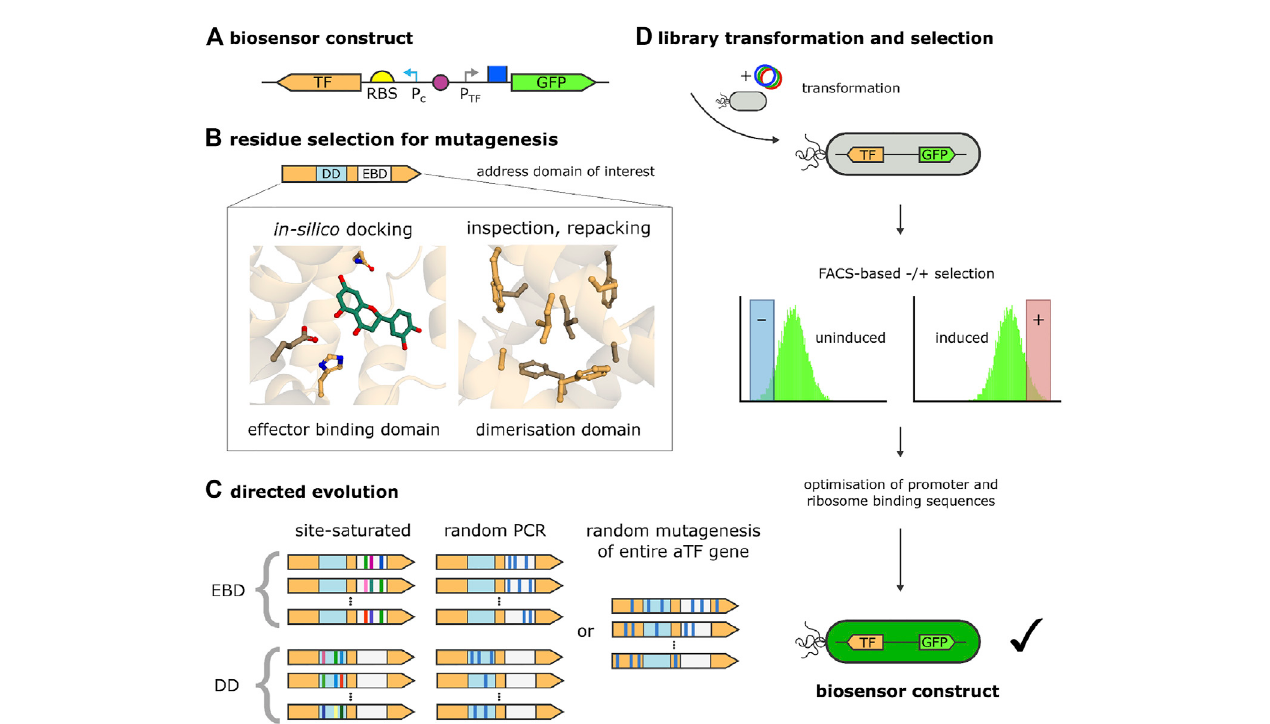
FIGURE 3 Biosensor development by directed evolution of the aTF. (A) Biosensor construct on one plasmid, composed of the sensor component, which, in turn, contains the transcription factor (TF) gene with a ribosome binding site (RBS) and a consecutively active promoter (P c ), and the reporter component, comprised of a TF-inducible promoter (P TF ) and a reporter gene (green fl uorescent protein, GFP). (B) Biosensor mutagenesis strategies. Depending on the availability ofstructuralinformation, adomainofinterestoftheTF(e.g.,theeffectorbindingdomain,EBD,orthedimerisationdomain,DD)areinspected ormodeledandresiduesorsequencestretchesformutagenesisareselected.Toguidemutagenesis,ligandscanbeplacedintotheEBDwith insilico -docking and side chains can be designed and repacked (e.g., in the DD). (C) Directed evolution strategies. Based on the residues or sequence stretches selected, the domain of interest is addressed (EBD or DD in the current examples) by rational approaches, i.e., site-directed mutagenesis or random/error-prone PCR. Alternatively, the complete aTF gene is targeted with random mutagenesis in the absence of structural information, or if non-intuitive effects should be probed (e.g., those affecting allostery or DNA binding). During site-directed mutagenesis, combinations of amino acids are generated for selected, fi xed sequence positions (this is represented in the picture by different colors at identical sequence positions). (D) The library of sensor constructs obtained by directedevolutionistransformedintocells,whicharethensubjectedto(usually)multipleroundsofnegativeselection(non-inducedsensorintheabsenceof effector) and positive selection (induced sensor in the presence of effector), facilitated by fl uorescence-activated cell sorting (FACS) [after (Machado and Dixon, 2022)]. The best candidates are further optimised with respect to other genetic elements determining the fi delity of the bio-sensor, such as RBS and promoter